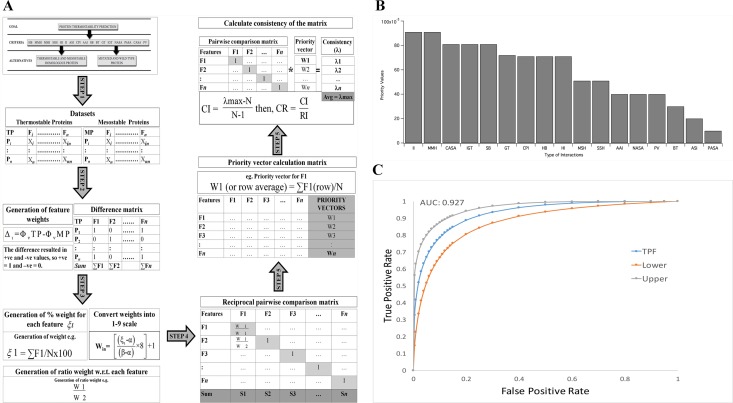
The rationalized method for predictioin of thermostability of proteins.A The hierarchy of thermostability is composed of three tiers. First tier is the goal and second is the criteria. The third tier was the alternatives. The alternatives are a set of wild type or engineered proteins. In Step 1 the 127 thermostable and mesostable proteins along with their 17 features form a 127x17 matrix, where TP: Thermostable proteins; MP: Mesostable proteins; F: features where i⋯n represents number of features; P: Protein ID where i⋯n stands for the number of proteins. In Step 2 feature weights are generated where, Δ_l: difference in the normalized feature; l = i⋯n features, ΦTP: normalized feature of the TP set; Φ_(v) MP: normalized feature of the MP set. Then the difference in the features was represented by vectors where each difference in attribute, Δ_l takes the value of 1 if the feature of type F is positive, and 0 if F is negative or there is no difference. Further the number of proteins in the difference matrix having the value of 1 for each of the features was summed. In Step 3, percentage weight showing increase, ξι w.r.t. the total number of thermostable proteins, N = 127, and ι = 1⋯n features was derived and converted into the 1–9 scale where, W_in is the converted weight, in = 1⋯n features, α is the minimum value in the weight for feature and β is the maximum value in the weight of feature. This weight was further converted to ratio weight for each feature. In Step 4 this ratio was supplied to a pairwise comparison matrix. In Step 5, calculation of eigen or priority vectors was performed by calculating the sum of the column Sn where n = 1⋯n features. In Step 6, Consistency index (CI) was derived by calculating λmax which is the consistency measure of each row which is calculated as the dot product of pairwise comparison matrix with the priority vector matrix which is then divided by N, where N = total number of features. Further, consistency ratio (CR) was derived and according to Alonso et al. (2006), RI is a random index and is equal to 1.6086 for N = 17. B The priority values obtained by AHP for the 17 significant thermostabilizing features. The scale is from 0–1. The highest ranked features were ionic interactions (II) and Main-chain–main-chain hydrogen bonds. The abbreviations have been provided in the beginning of the paper. (C) Receiver operating characteristic curve obtained by Leave one out Cross Validation, fitted by maximum likelihood estimation by LABROC4 for ranks of 100 thermostable proteins w.r.t. mesostable homologous proteins obtained by RankProt. The Area Under Curve (AUC) was calculated to be 0.927.